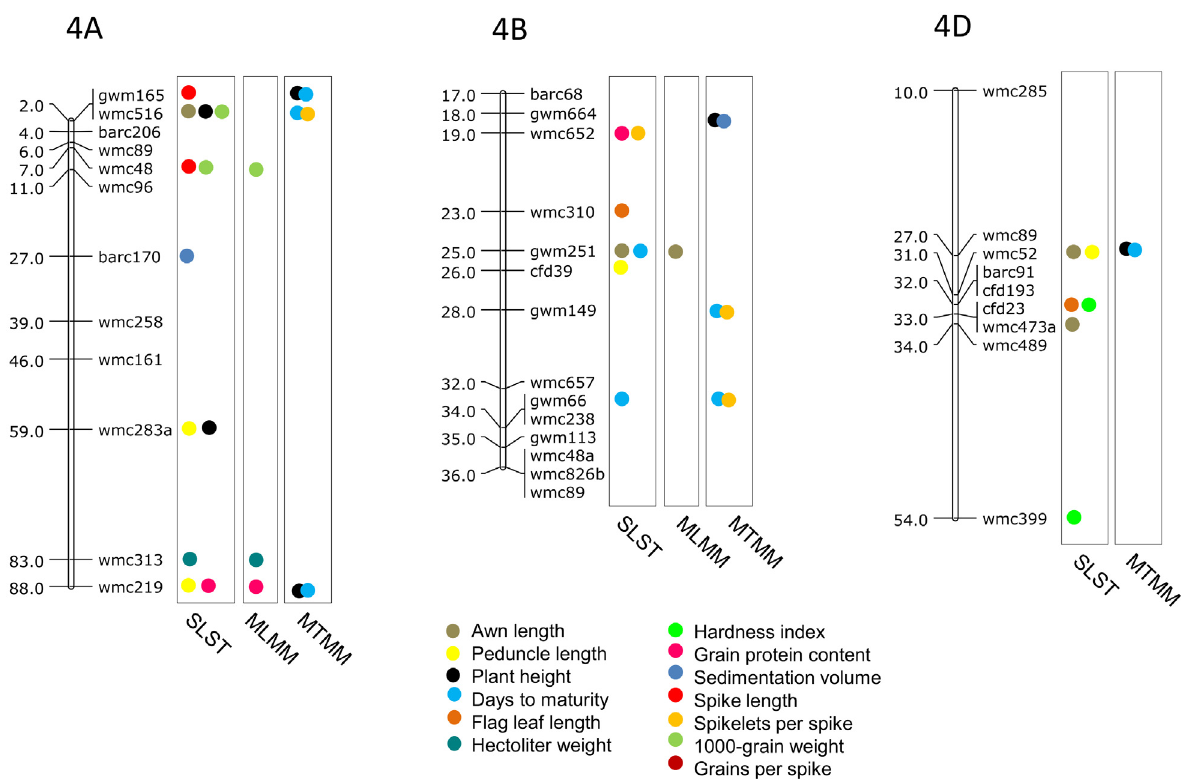
Fig 6. SSR genetic linkage maps of homoeologous group 4 chromosomes showing markers-trait associations (markers associated with different traits are shown by solid circles with different colours); markers are indicated to the right and map distances (cM) are indicated to the left of the vertical bar (based on the consensus linkage map of Somers et al. [76].